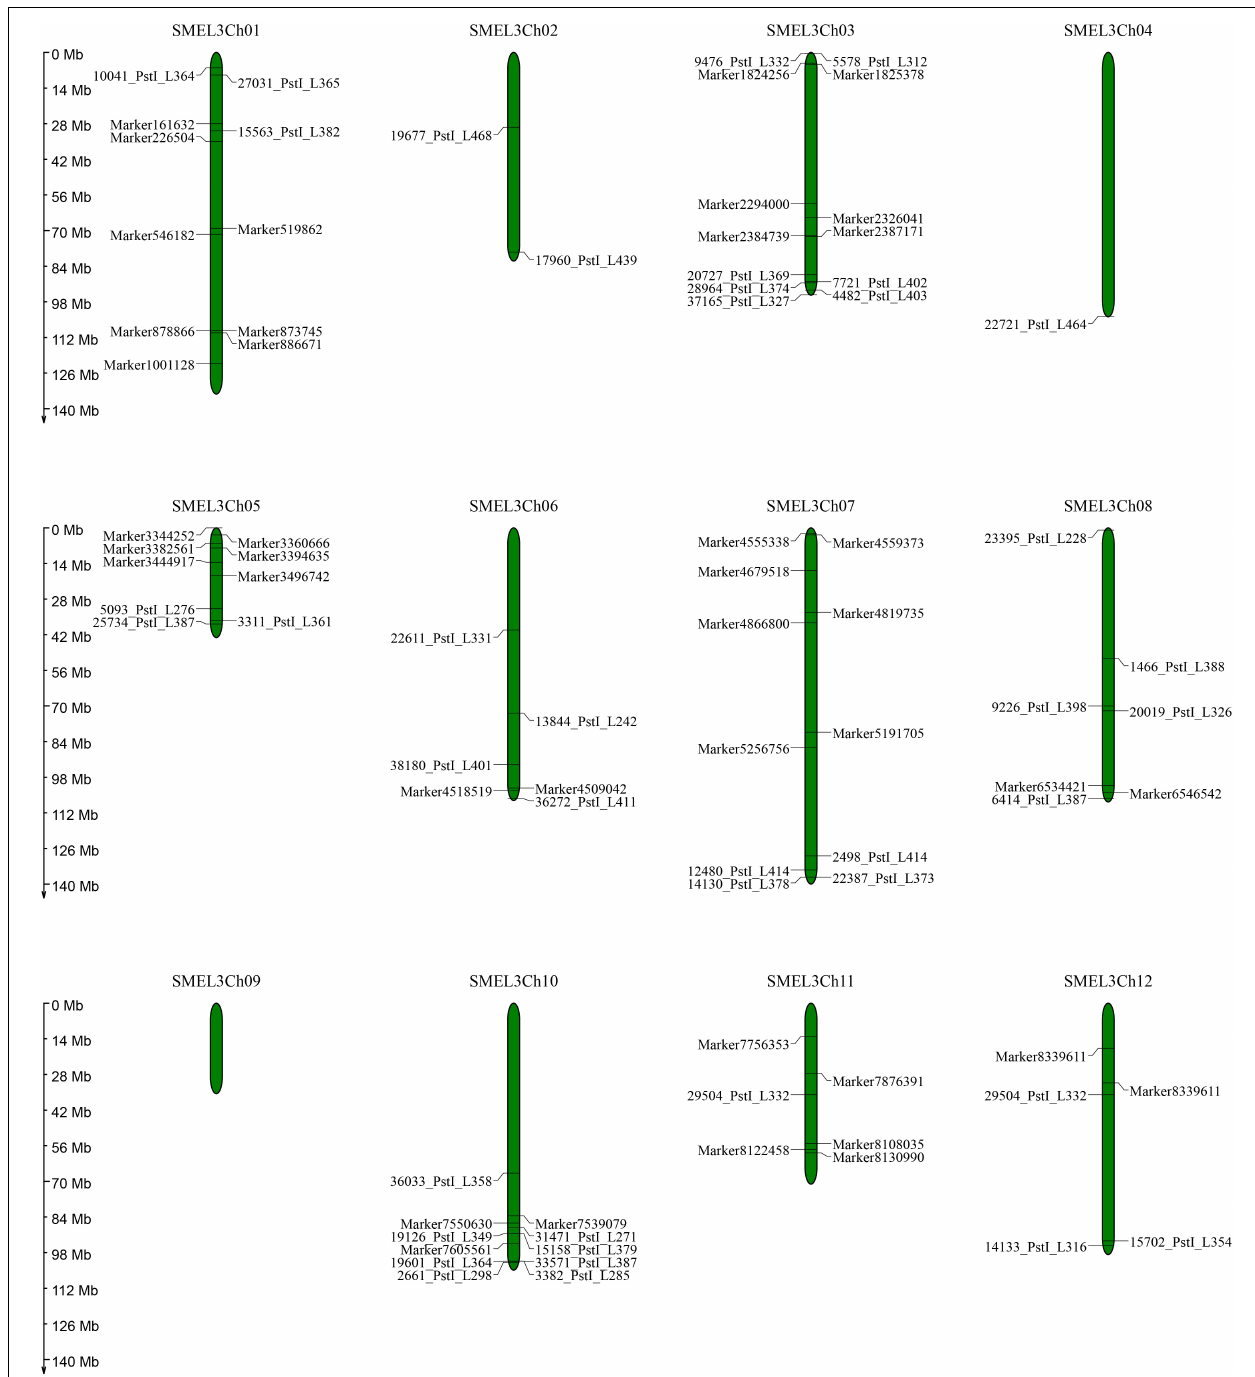
FIGURE 3 | Graphic view of the distribution of markers associated with related traits on eggplant chromosomes.